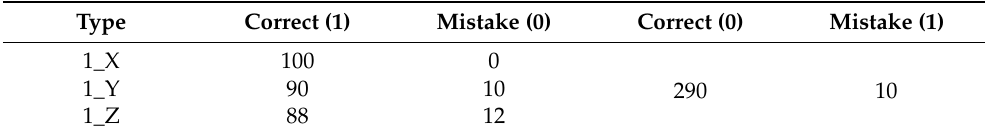
Table 9. Results of the